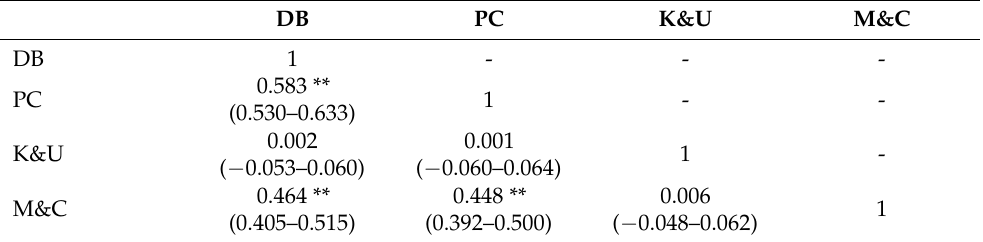
Table 3. Correlations between physical literacy domain scores in normal weight children.